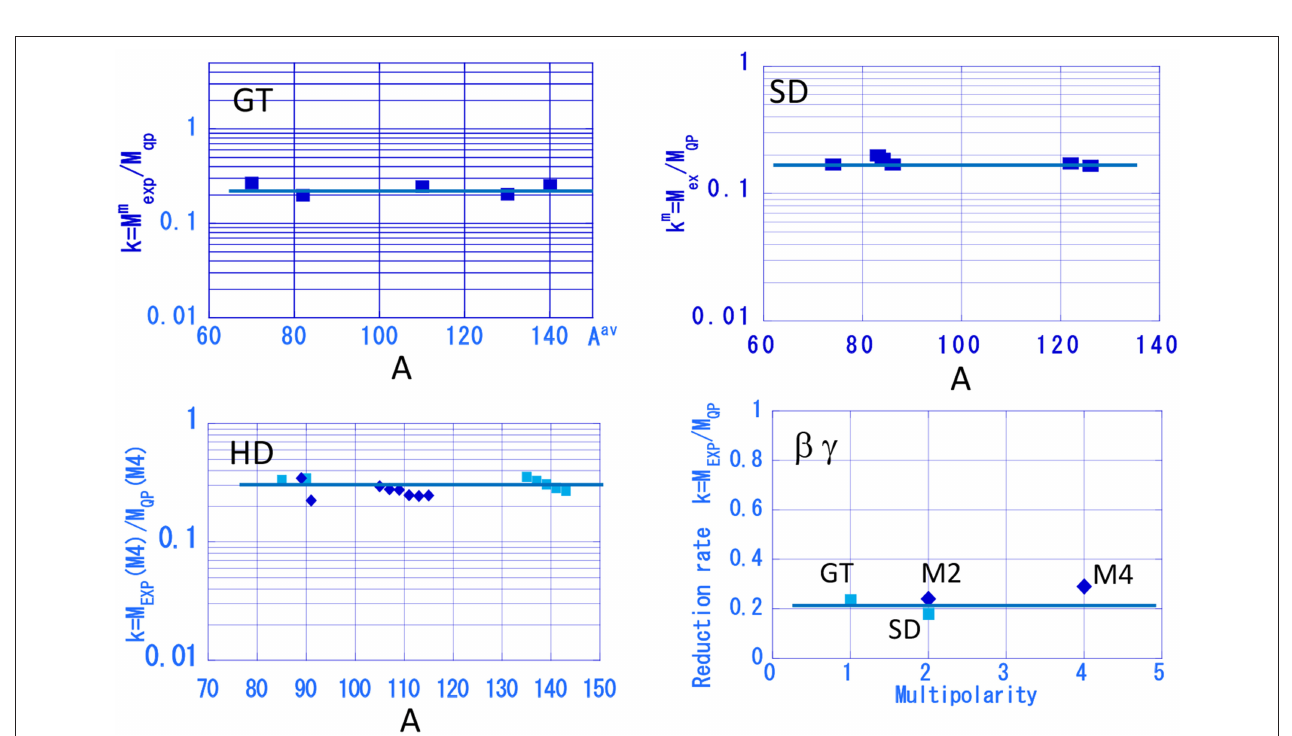
FIGURE 4 | Spin dipole (SD) NMEs obtained from the ( 3 He, t ) CER cross sections are plotted against the FSQP model SD NMEs for DBD nuclei. (Left Panel) SD NMEs derived by referring to the GT NMEs. (Right Panel) SD NMEs derived by referring to the F NMEs. A, B, and C are the NMEs for the nuclei with the mass A = 76 and 82, 96 and 100, and 128, 130 and 136. See Ejiri and Frekers [18].